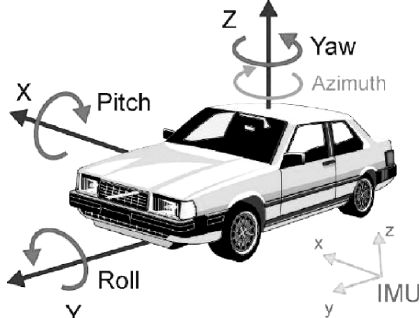
Figure 3. IMU angle